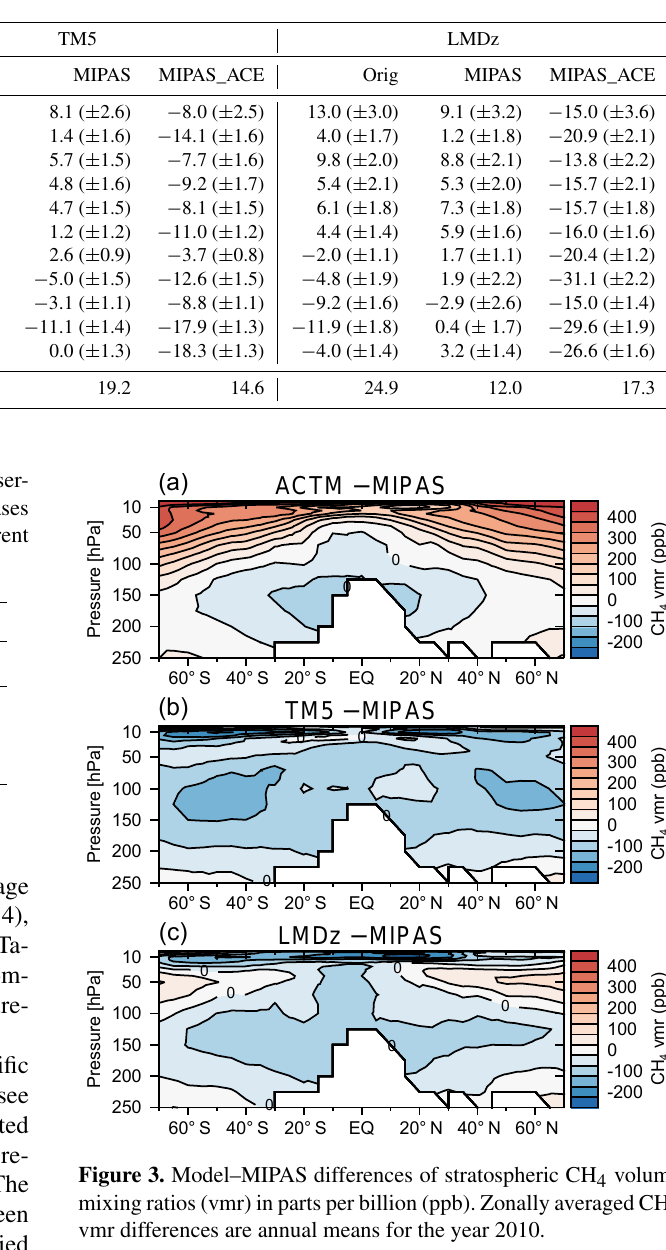
PAS CH 4 fields (see Table 4). After this correction, site- specific LMDz XCH 4 biases lie between − 2 . 9 and 9.1 ppb. Using MIPAS_ACE CH 4 fields for the LMDz model cor- rection produces LMDz XCH 4 biases between − 13 . 8 and − 31 . 1 ppb. At the same time, the average LMDz XCH is increased from 6.8 to 20.0 ppb (Table